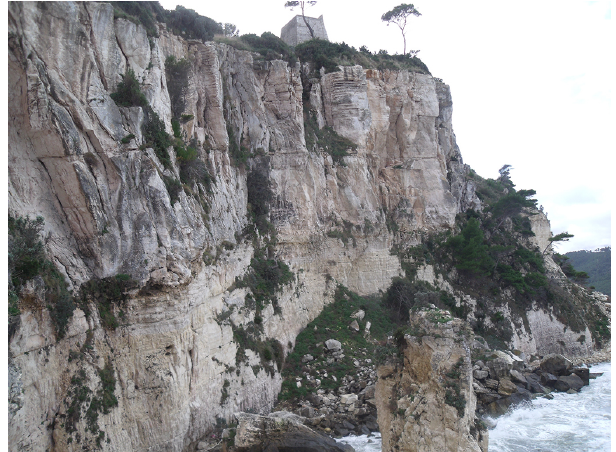
Fig. 3. Photo view of the Mt. Pucci cliff slope. View is to the east (see Fig. 2 for the location of the measurement points). From this location, some remote sensing-based surveys (TLS and IRT) were